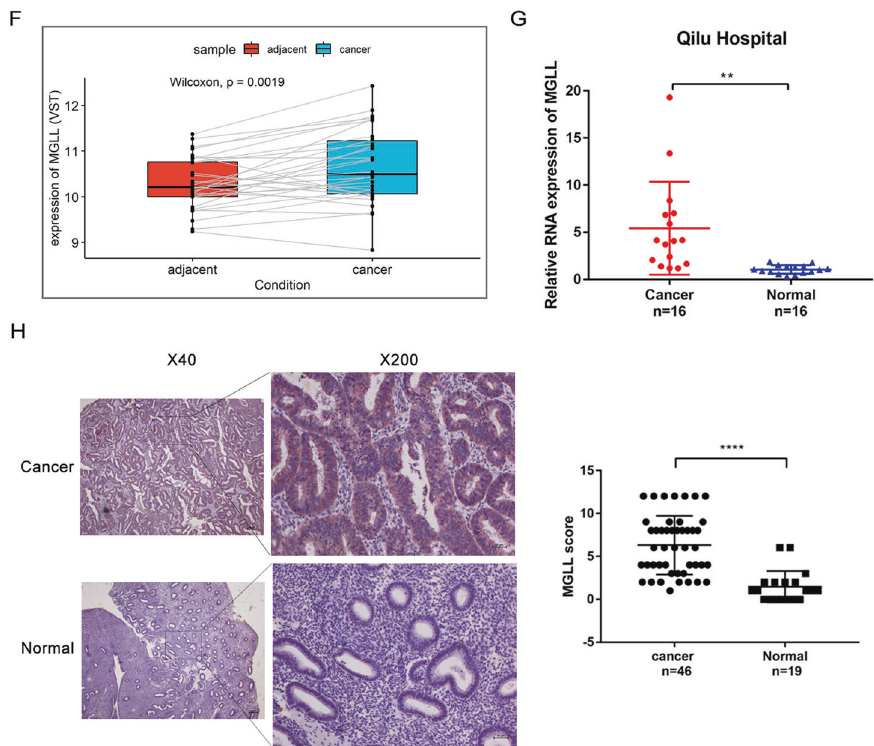
Fig. 1 MGLL is a key gene high expressed in EAC and correlated to the progesterone resistance. A Hierarchically clustered heatmap of differentially expressed genes in IshMR and Ish cells. B Volcano plot of RNA-seq from microarray data in IshMR and Ish cells. The green dots represent DEGs based on a |FC| of ≥ 3. The red dots represent MGLL. C The violin plot depicting the expression distribution of MGLL between IshMR and Ish cells. D MGLL protein level in Ish and IshMR cells. E Representative images of IHC staining of MGLL in endometrium before and after progesterone treatment in CR, PR, and NR/PD group. MGLL IHC scores in endometrium before and after progesterone treatment were analyzed by Image-Pro Plus 6.0. The Score = (percentage of cells of weak intensity × 1) + (percentage of cells of moderate intensity × 2) + (percentage of cells of strong intensity × 3). F Validation of MGLL expression in EC and adjacent samples from GEO databases, GSE183185. The mRNA level of MGLL was analyzed with the “ limma R ” package using Student ’ s t test. G MGLL mRNA level in 16 EAC tissues and its adjacent tissues. H Representative images of IHC staining of MGLL in EAC and normal tissues. CR complete response, PR partial response, NR/PD no response/progression disease, Ish Ishikawa cells, IshMR MPA-resistant cell line of Ish cells. * P < 0.05, ** P < 0.01, *** P < 0.001 and **** P < 0.0001 for statistical analysis of the indicated